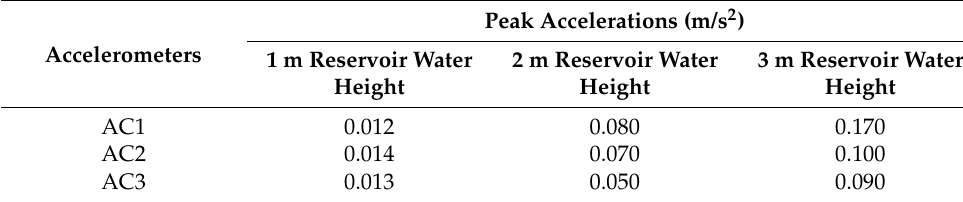
Table 13. Peak values of accelerations for the IBS frame.